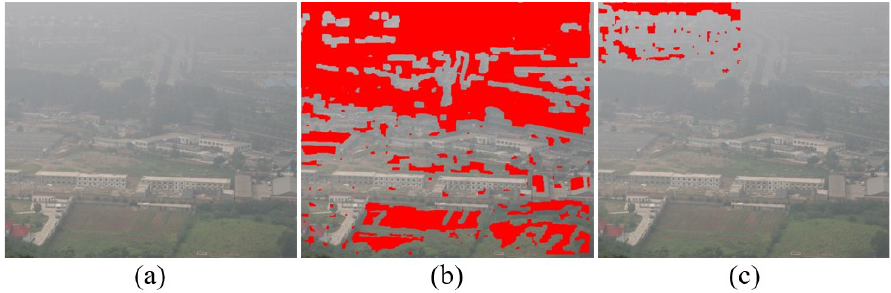
Figure 2. Region of interests for the candidate atmospheric light pixels: ( a ) input hazy image [11], reproduced with permission from [11], IEEE, 2014, ( b ) Sulami’s method [11], and ( c ) the proposed